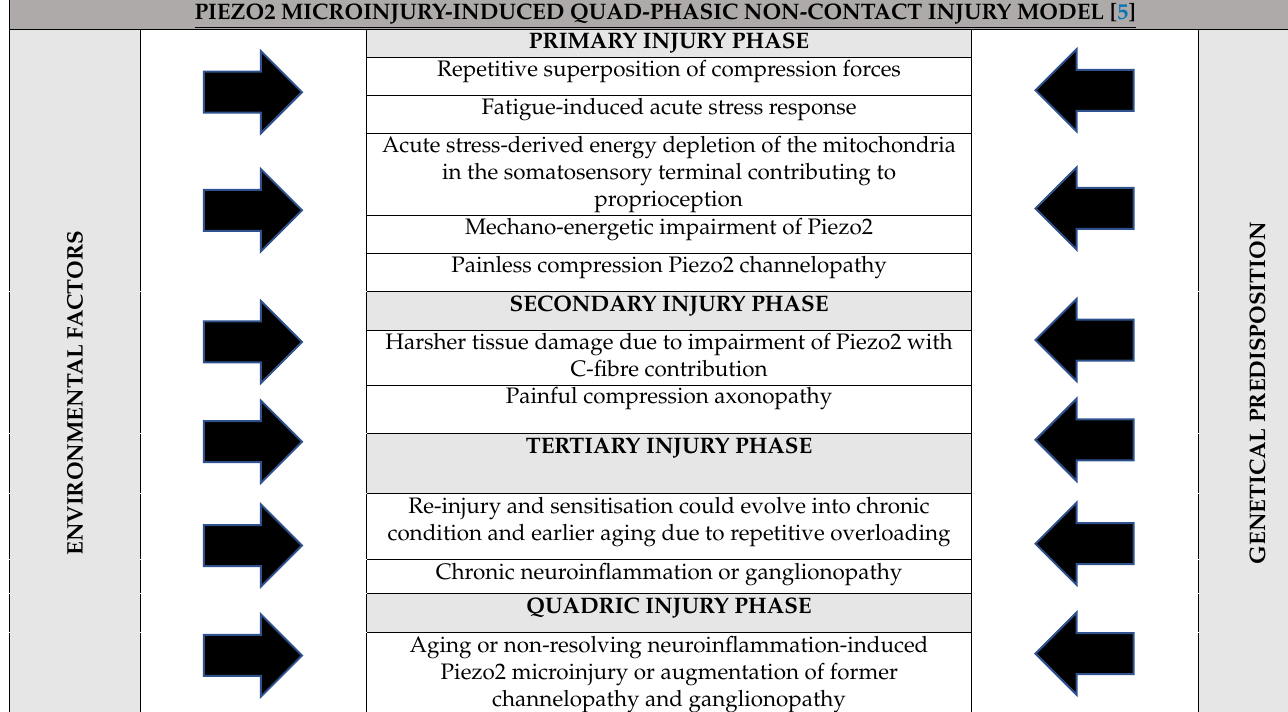
Table 1. The quad-phasic non-contact injury model [5].